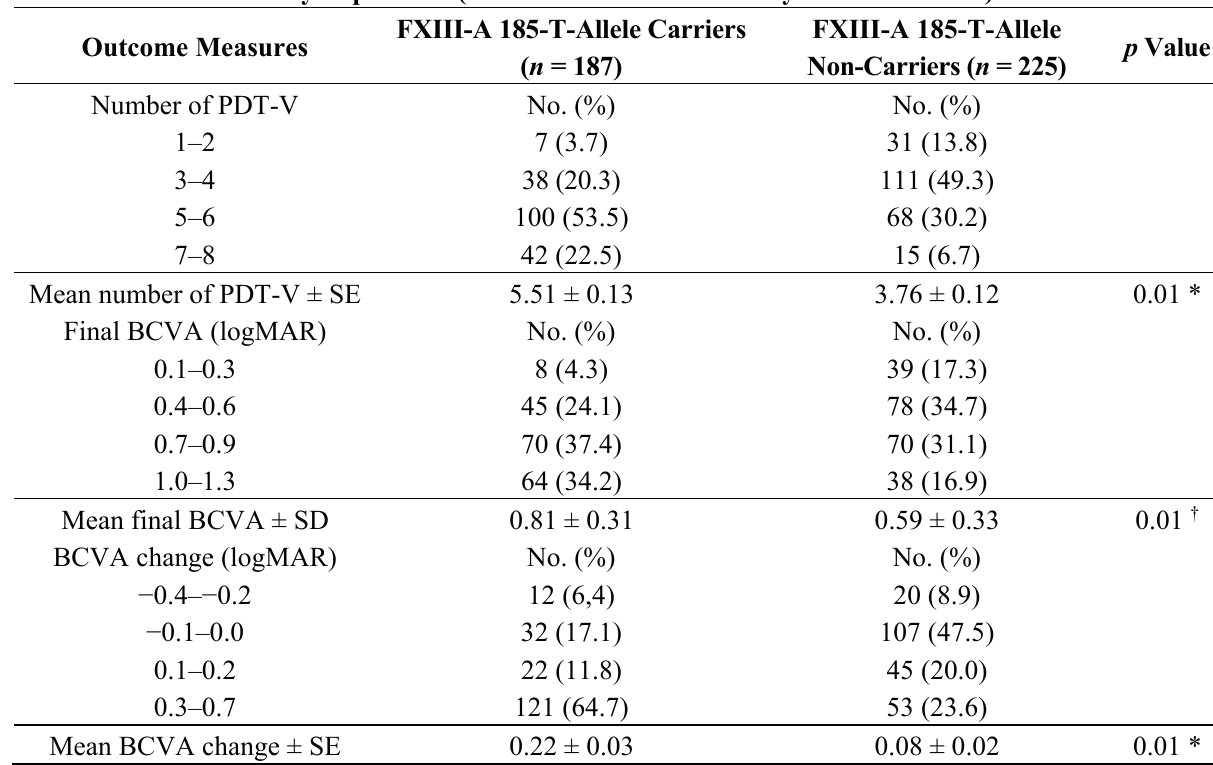
Table 2. Comparative analyses of clinical outcomes between factor XIII-A 185-T-allele carriers (patients with GT or TT polymorphic genotypes) and non-carriers (patients with wild-GG